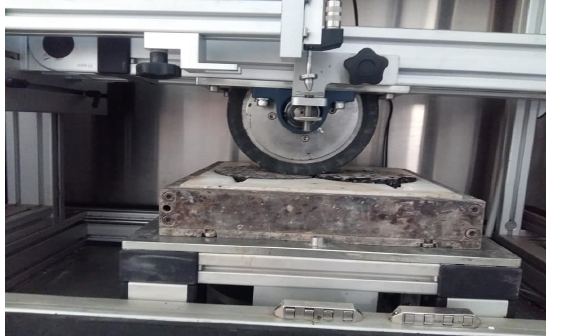
Fig. 6: Loaded Wheel Tracker